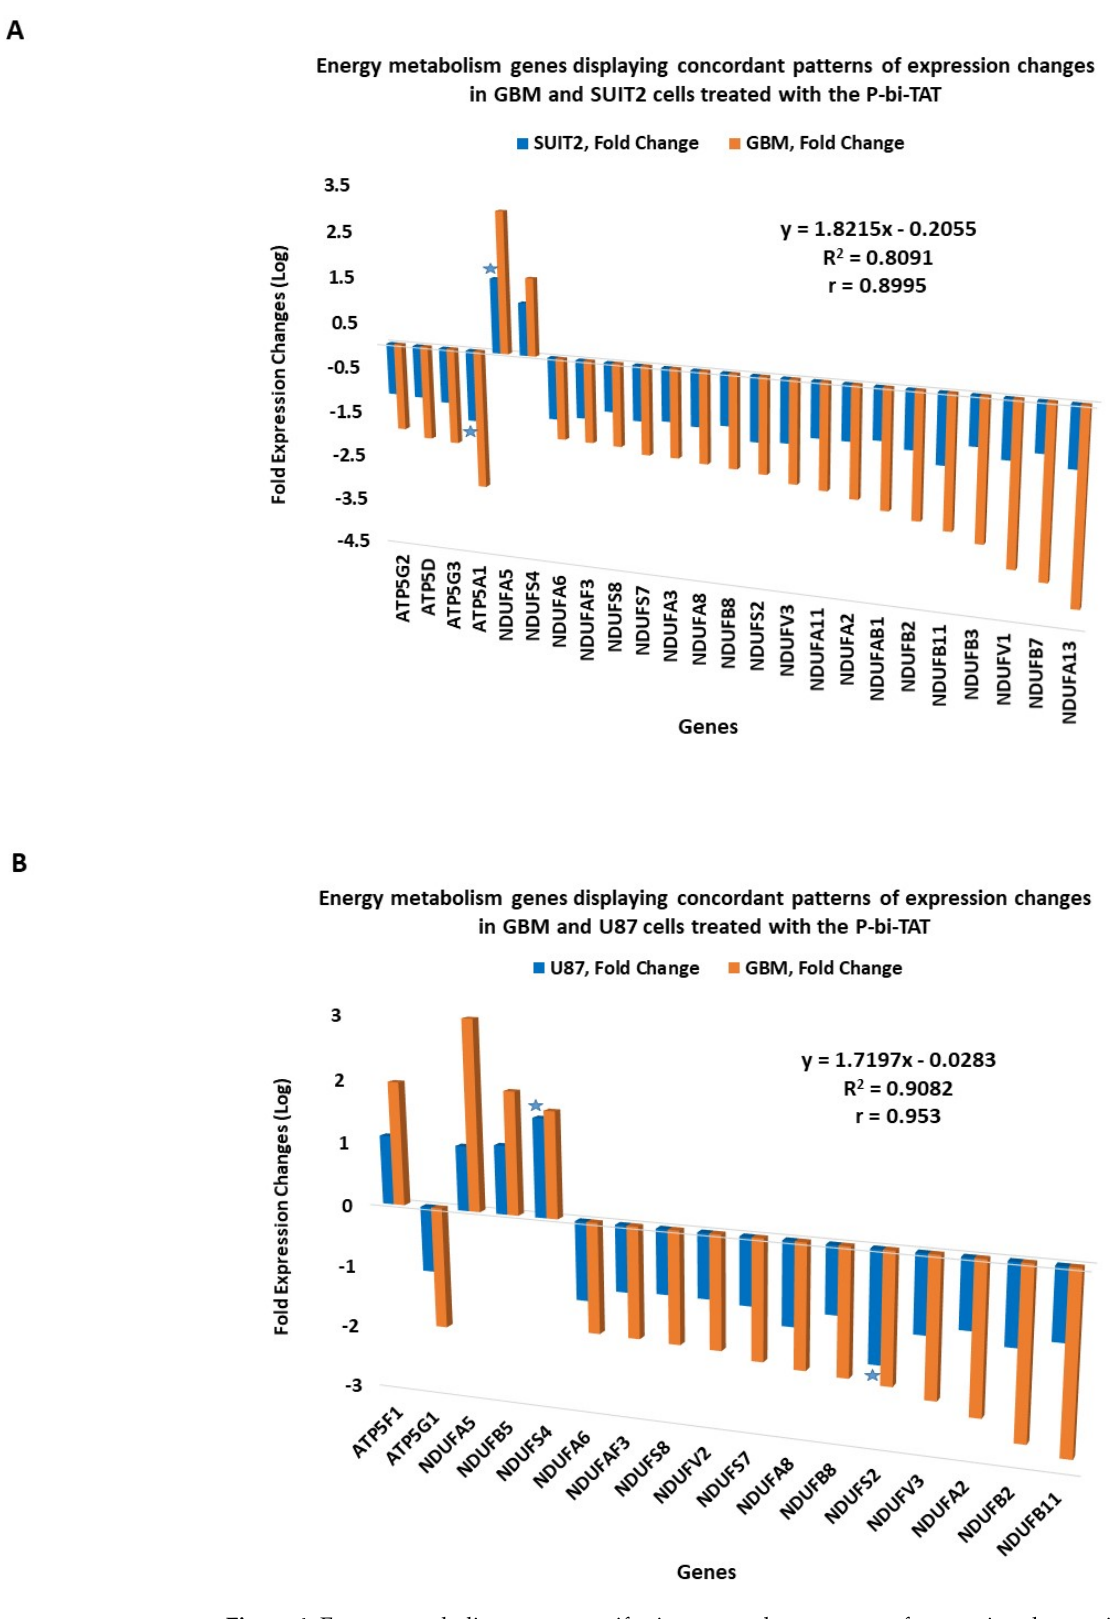
Figure 4. Energy metabolism genes manifesting concordant patterns of expression changes in primary culture GBM (PC-GBM) cells and established human cancer cell lines treated with the thyrointegrin inhibitor P-bi-TAT. ( A ) Pancreatic cancer SUIT2 cell line and ( B ) U87MG GBM cell line. Stars denote genes manifesting largest fold expression changes in corresponding established cancer cell lines.